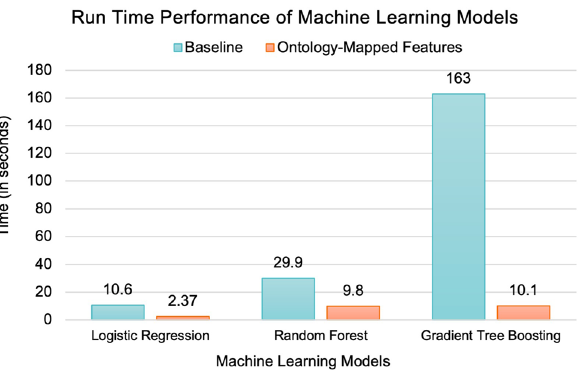
Figure 5. Run time performance of the three machine learning models without ontology-based mappings (baseline) and with mappings of both input as well as output